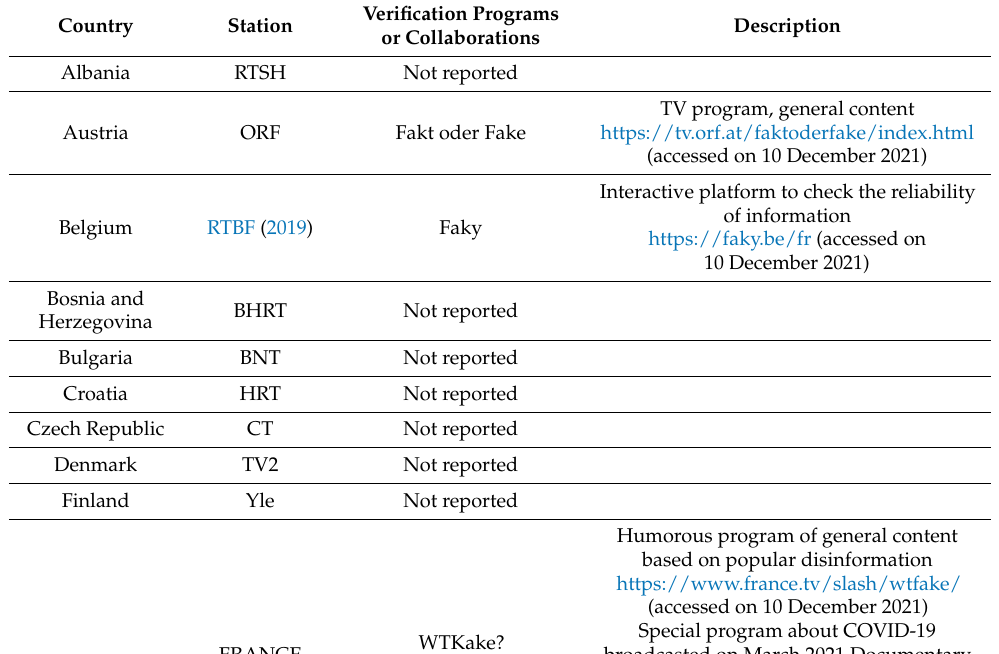
Table 1. Programs and Information Verification Resources in CIRCOM